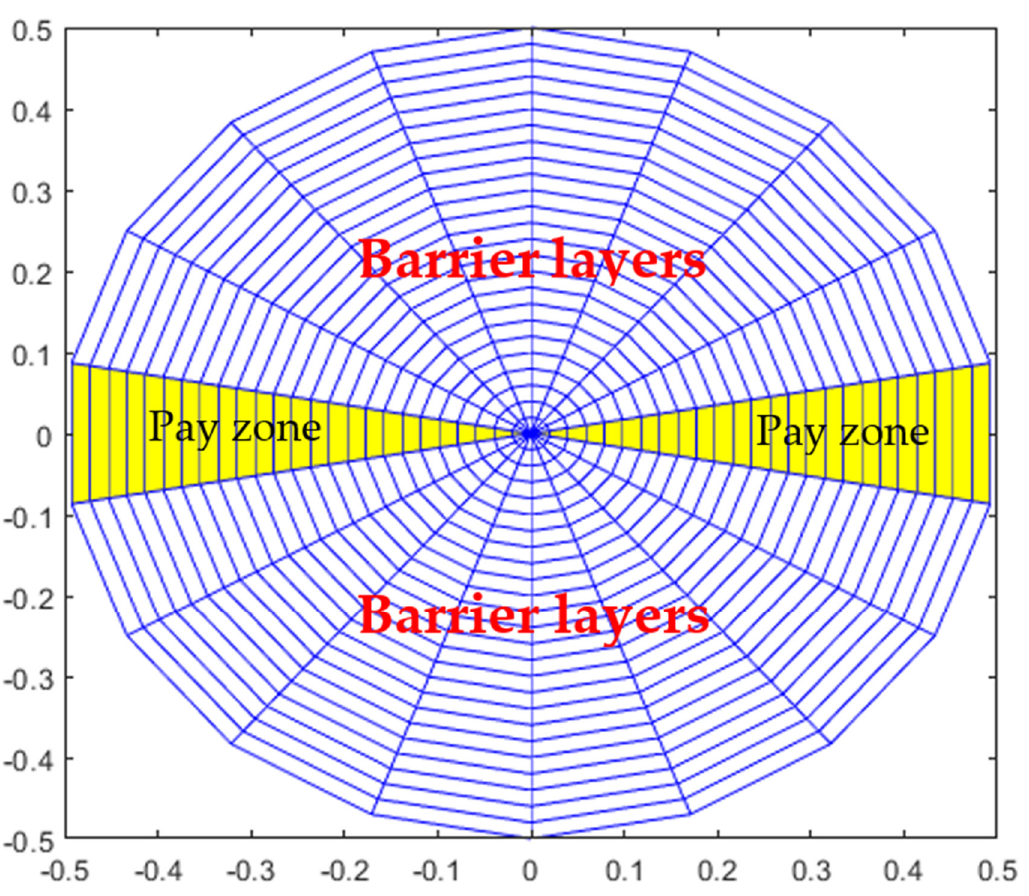
Figure 4. The discrete grid of initial fracture and the locations of the pay zone and the barrier layers.